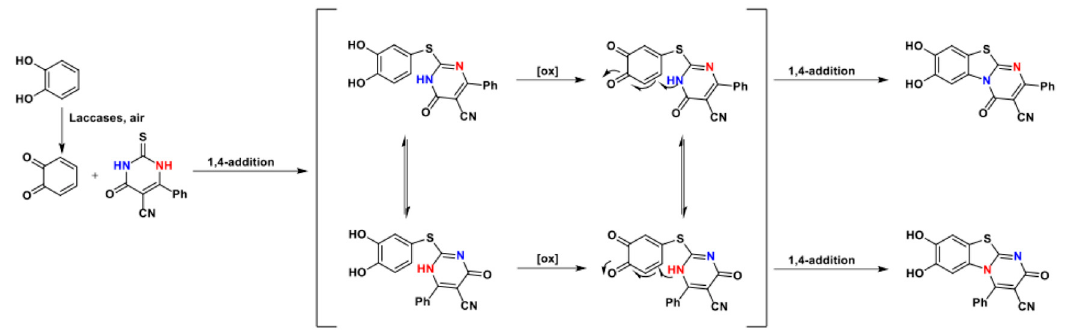
Scheme 33. Biocatalytic entry to pyrimidinyl benzothiazoles [28]. The complex regiochemical outcome of this domino process was further investigated by using cathecol and a sterically demanding 2-thioxo pyrimidine, as shown in Scheme 34.